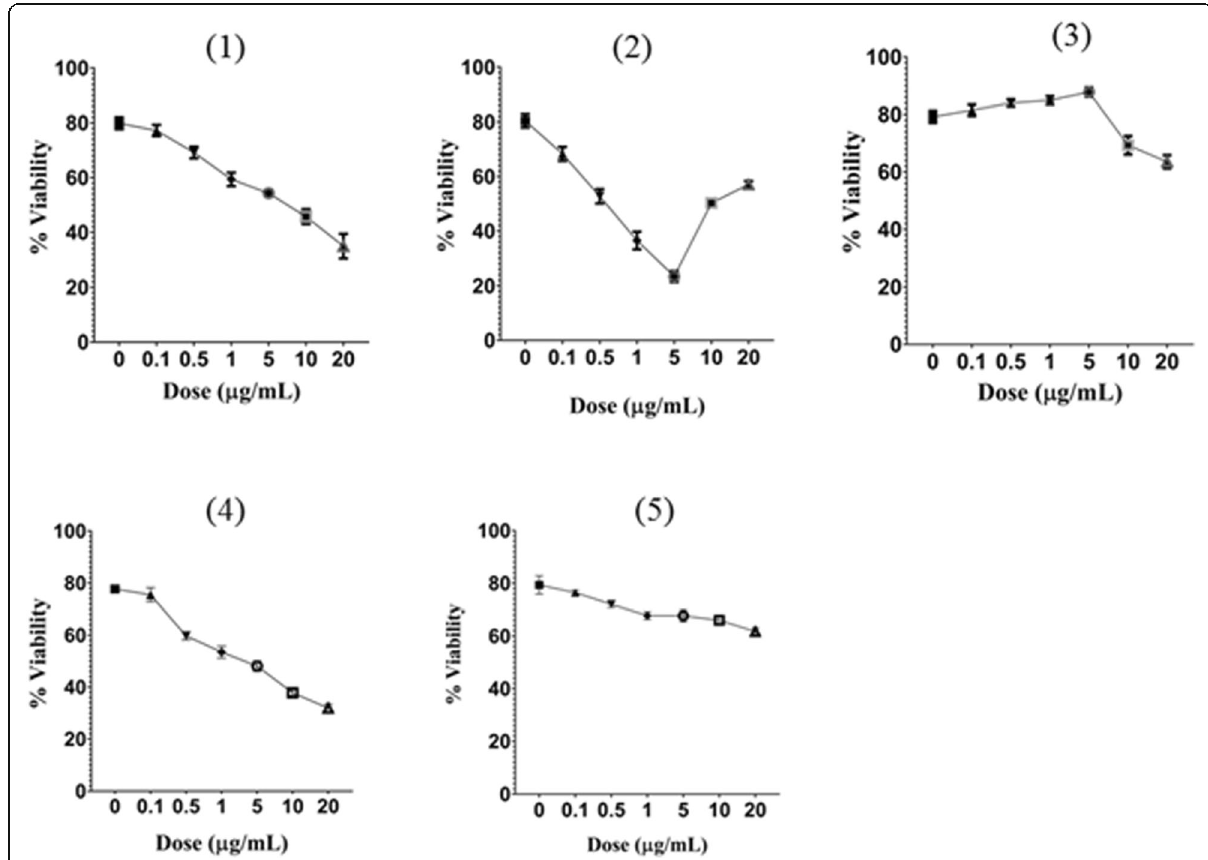
Fig. 2 Dose-response curves for the effects of isolated compounds on Vero cells. x-axis represents percentage of cell viability and y-axis represents concentration of samples of each